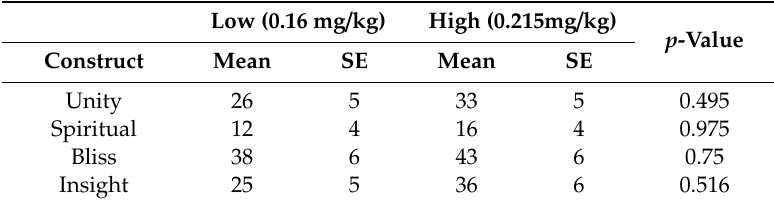
Table 1. Comparison between doses on sub-scales.